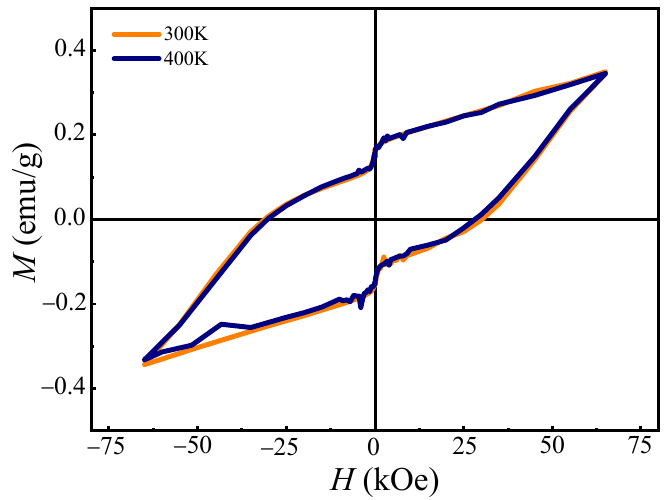
Figure 5. M-H hysteresis loops of the LFRO powders measured at 300 and 400 K, respectively. The appearance of this peak is generally considered to be resulting from the super- paramagnetic or spin glass behavior of the sample [56]. As demonstrated in Figure S3a, below the peak temperature, the M FC increases slowly with decreasing the